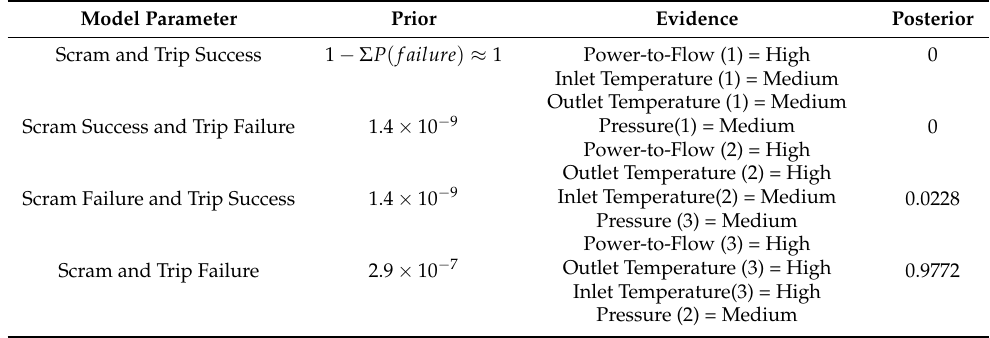
Table 5. Prior and posterior probabilities of scram, prognostics, and system diagnostics based on the listed evidence.